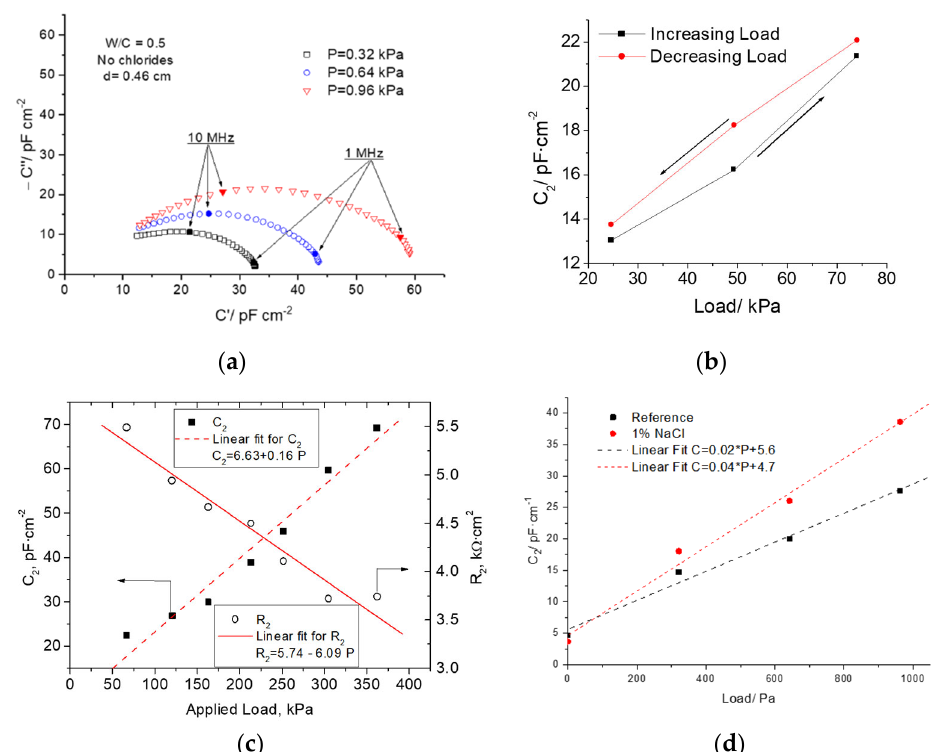
Figure 7. ( a ) Dependence of the complex capacitance on the applied load. ( b ) Variation of C 2 parameter on a loading ‐ unloading cycle (two minutes/cycle). ( c ) Dependence of the R 2 and C 2 parameters on the applied load. ( d ) Dependence of the C 2 parameter on the applied load for two cement chemistries, with and without chlorides. Figures ( b , c ) are taken from [38], Figures ( a , d ) from [39].